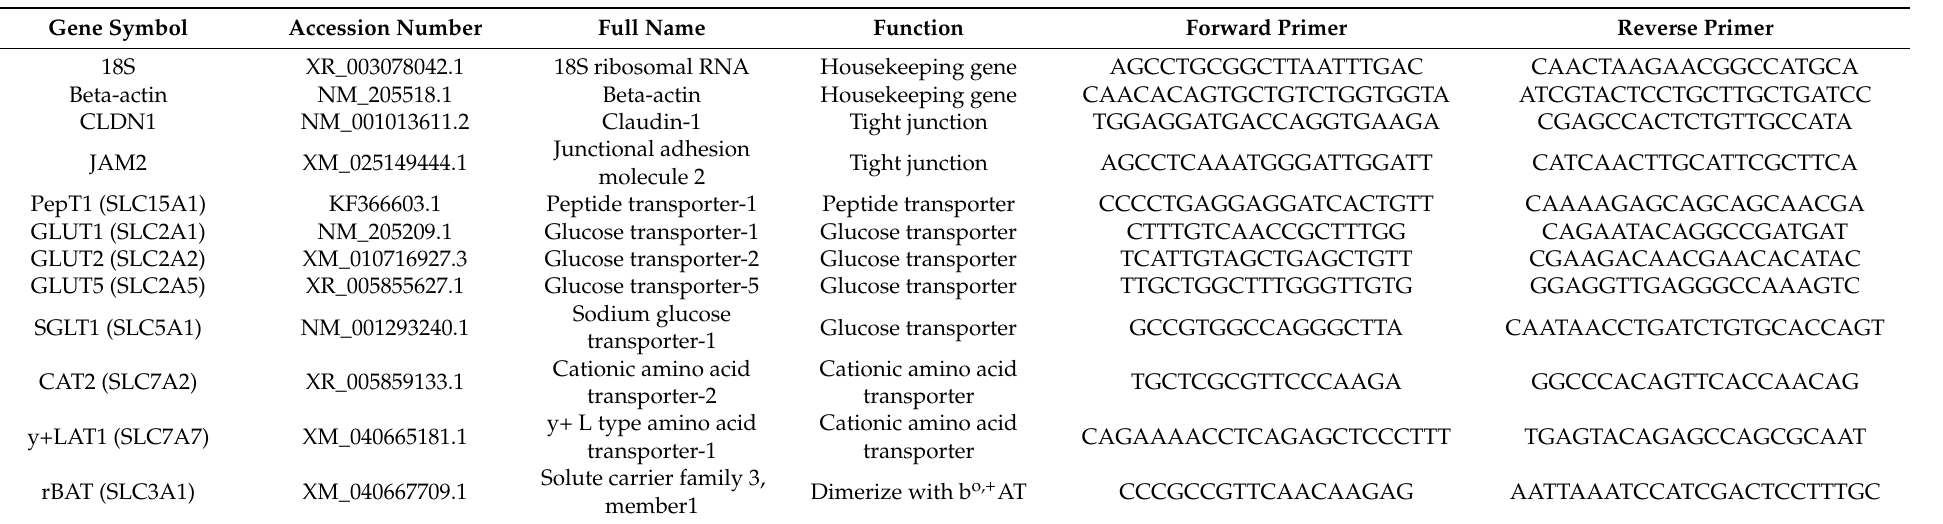
Table 3. GenBank accession number, sequences of forward and reverse primers used for real-time